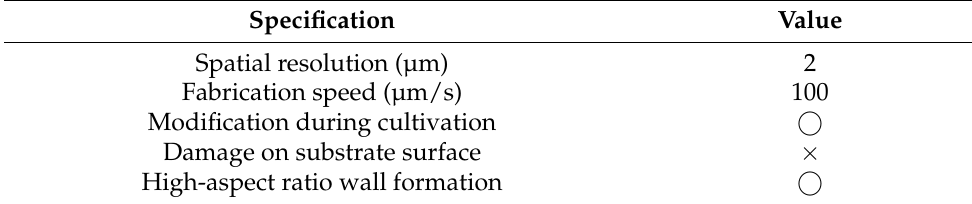
Table 1. Summary of photothermal agarose microfabrication technology. Specification Value Spatial resolution (µm) 2 Fabrication speed (µm/s) 100 Modification during cultivation Damage on substrate